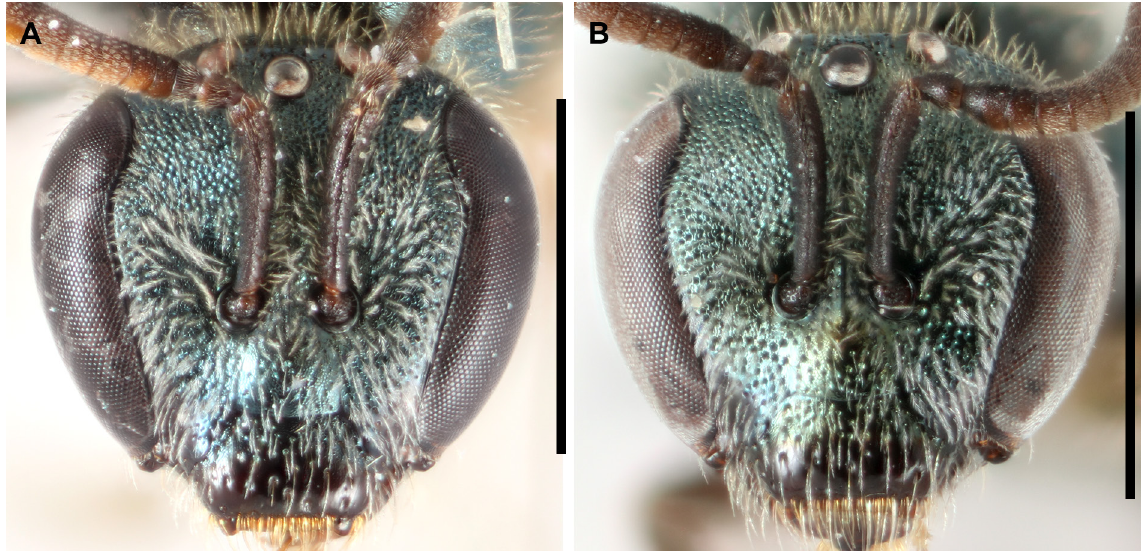
Fig. 101. Face. A . Lasioglossum puteulanum Gibbs, 2009, ♀, slightly longer. B . L. tegulare (Robertson, 1890), ♀, slightly shorter. Scale bars = 1